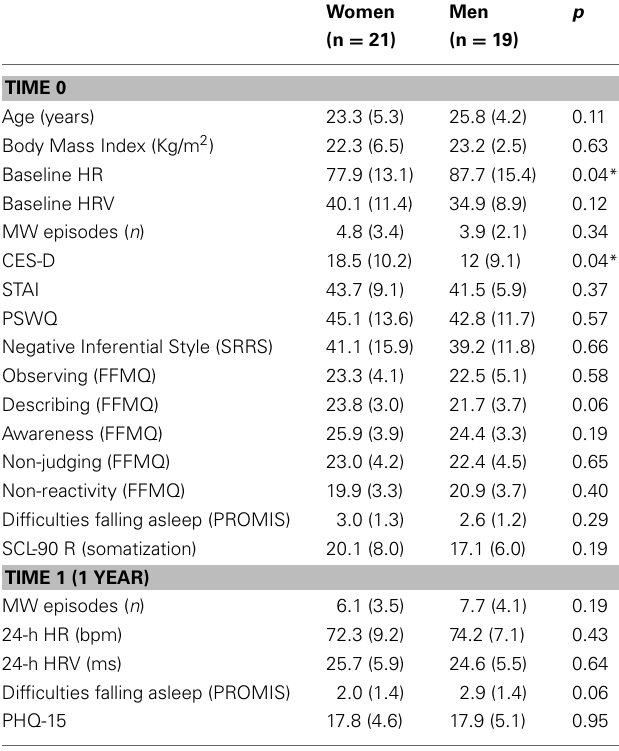
Table 1 | Sex differences for the main variables of the